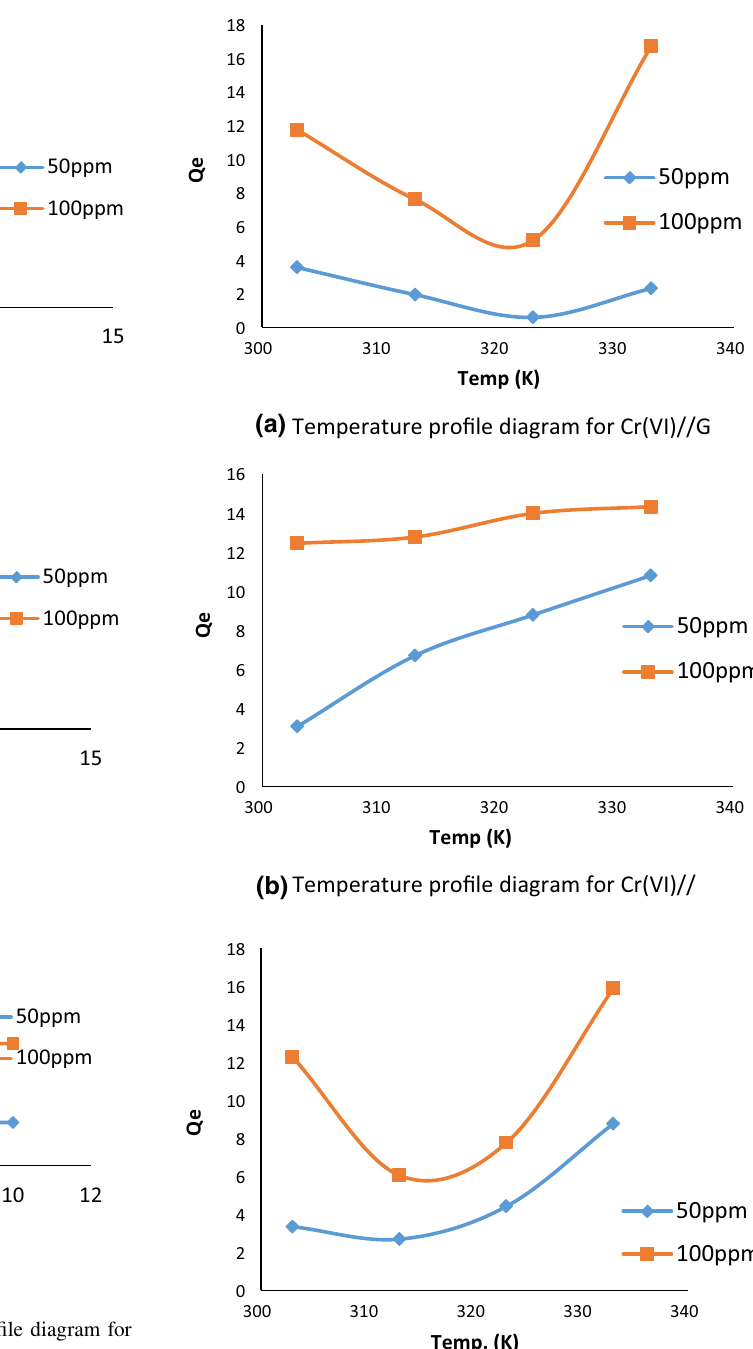
Fig. 7 a pH profile diagram for Cr(VI)//G, b pH profile diagram for Cr(VI)//AC, c pH profile diagram for Cr(VI)//GAC